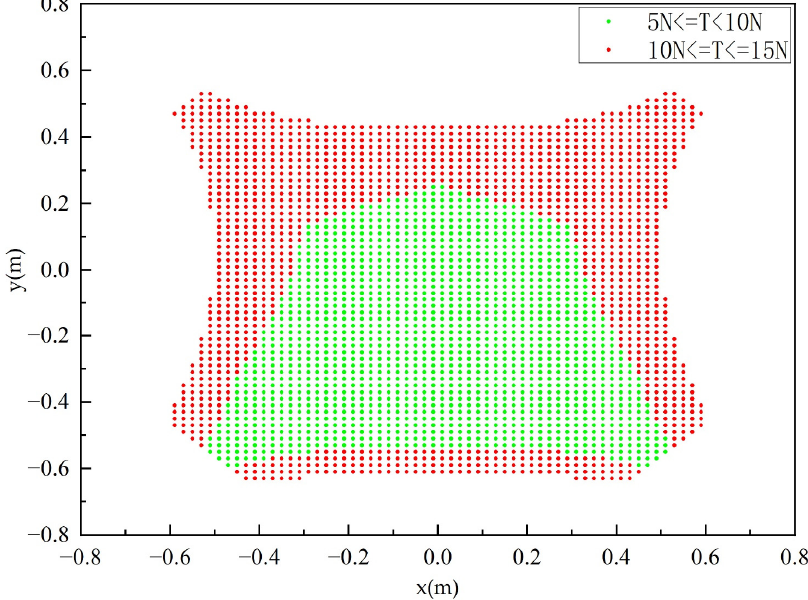
Figure 8. Tension distribution in force-feasible workspace.